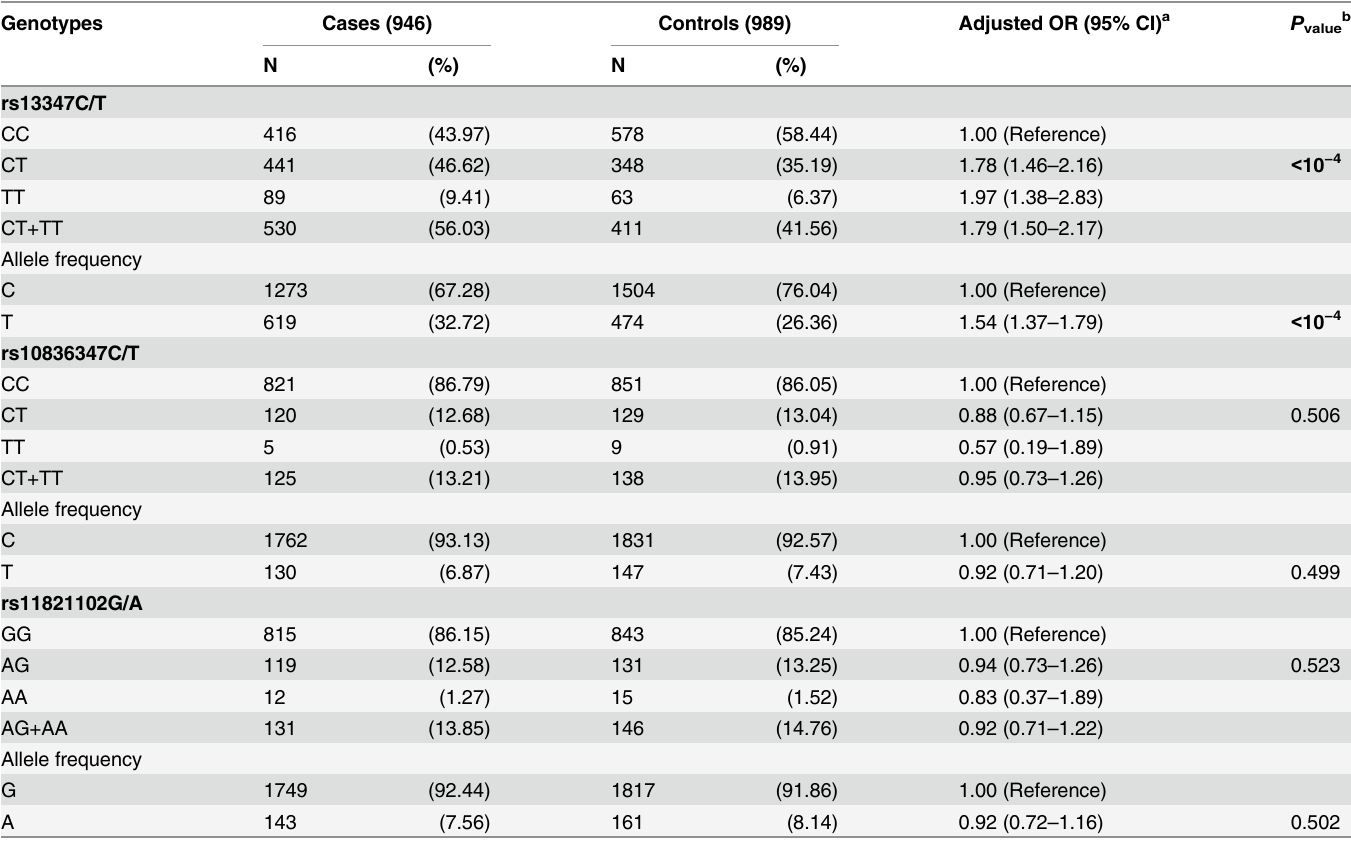
Table 2. Genotypes frequency of SNPs in 3 ’ -UTR of the CD44 gene in healthy controls and CRC patients and their association with CRC risk.